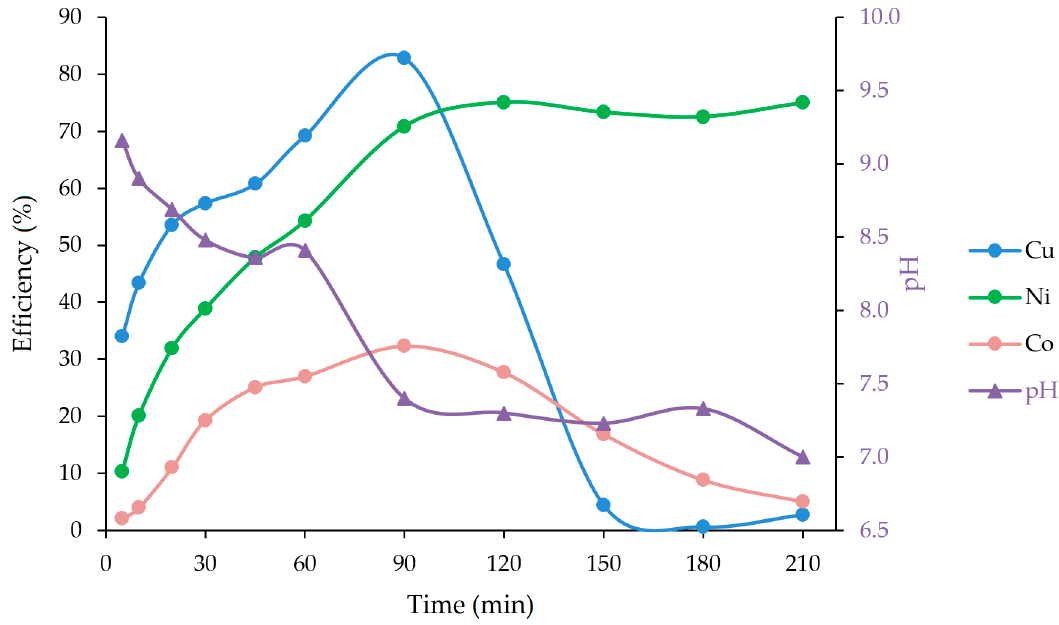
Figure 6. Kinetics of metals extraction during ammoniacal leaching with ultrasound at 85 °C.